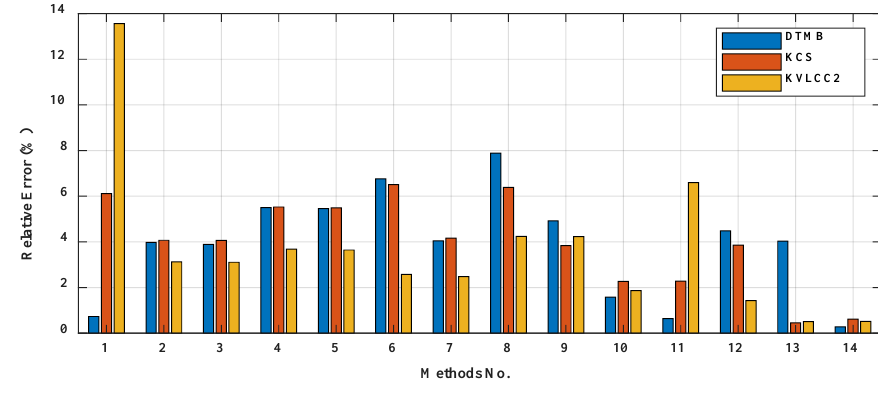
Figure 15. Comparison of WSAs.